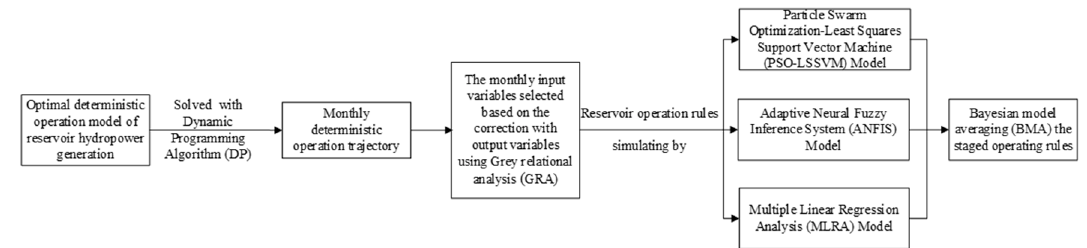
Figure 1. Flowchart for the derivation of GRA-BMA operating rules.